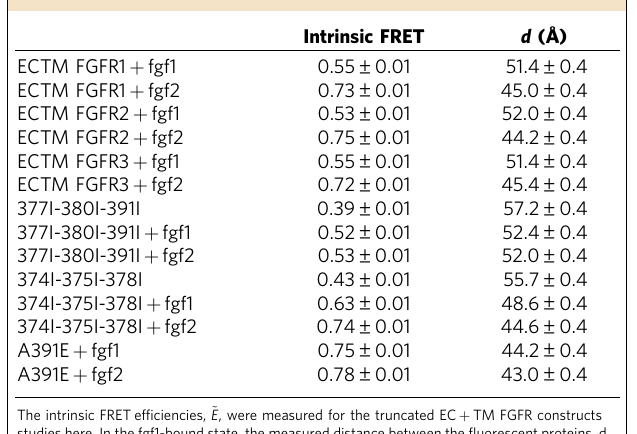
Table 2 | Intrinsic FRET efficiencies in the presence of saturating fgf1 or fgf2 concentrations.